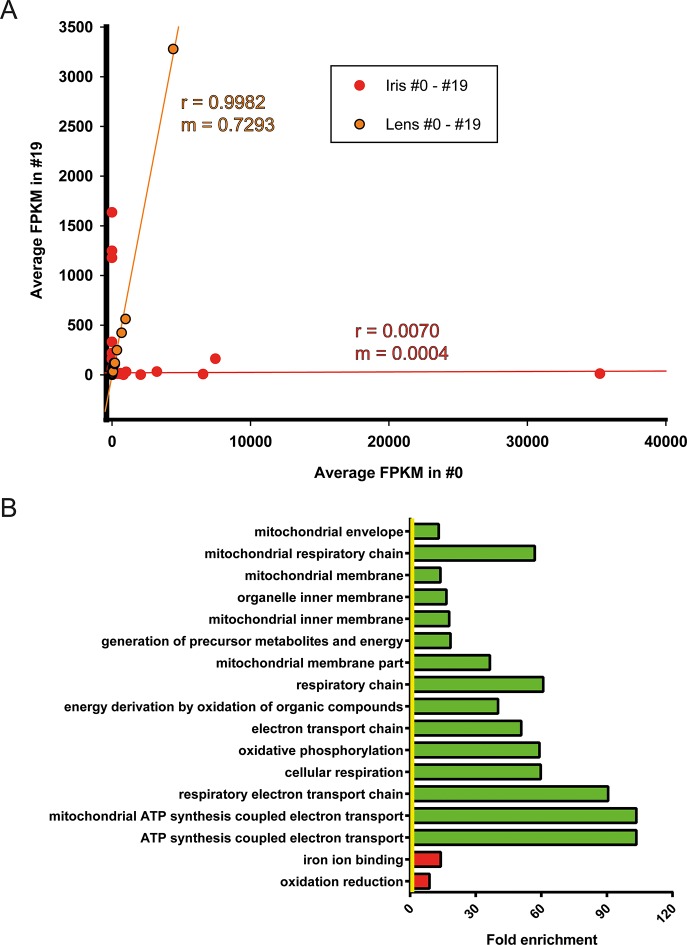
Correction of iris-regulated gene expression in the regenerated lens.(A) The 311 genes used for this analysis were differentially regulated in #0 versus #19 iris samples. Since lens is regenerated from the dorsal iris, the question arises whether or not these differences in gene expression are reflected in the regenerated lenses. Average fragment per kilobase per millions of reads (FPKM) values of these genes from iris and lens samples were plotted in the same graph. Red and orange colors mark the iris and lens, respectively. Linear regression analysis revealed that lens genes are more correlated (r = 0.9982) with m = 0.7293 while iris genes are not correlated (r = 0.0070) as expected. Based on the slope (m) values (where m = 1 is the absolute perfect when #0 and #19 values are identical), these data indicate that the #0 and #19 lens FPKM values differ approximately 27% while the equivalent iris samples are completely different. (B) Gene Ontology enrichment analysis of genes differentially expressed between #0 and #19 iris samples. Green and red bars denote gene groups in the down-regulated and up-regulated datasets, respectively. Yellow line marks fold enrichment of 1. Note that as with the tail samples, electron transport chain is also down-regulated in these samples, a sign of ageing.